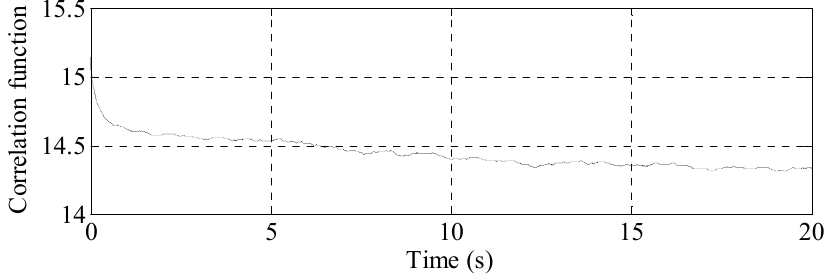
N in Equation (9) is chosen to be 1 Hz. tr